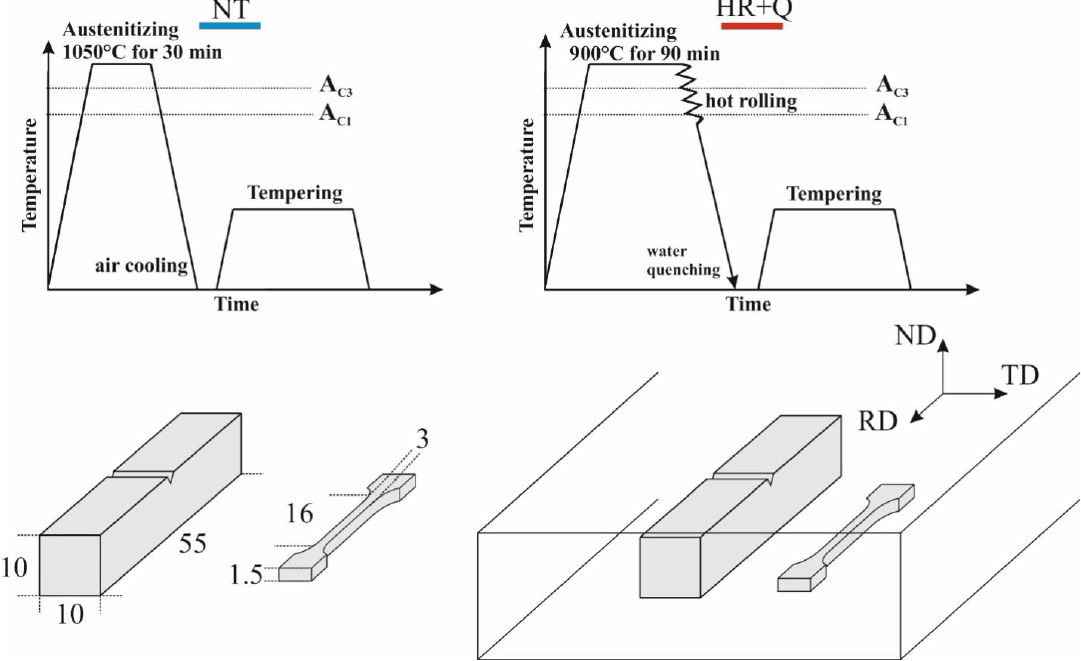
Figure 1. Schematic diagrams of thermal and thermo-mechanical heat treatments and schematic view of the rolled steel plate showing the orientation and dimensions of tensile and Charpy impact specimens (All dimensions are in mm).